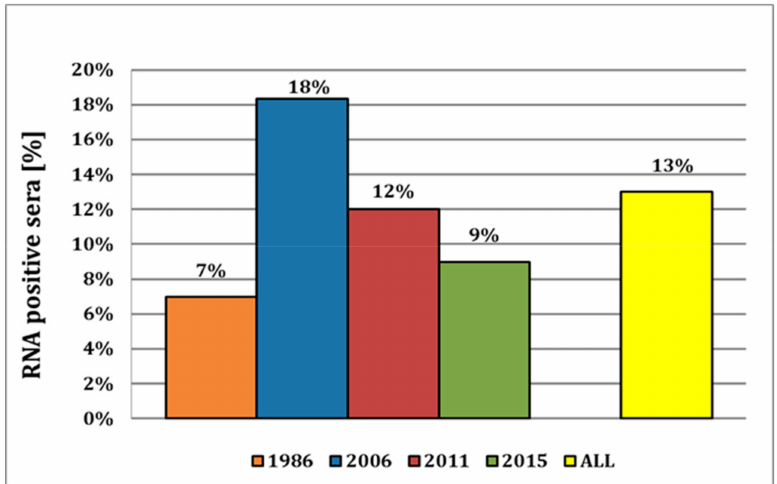
Figure 2. Virus prevalence of APPV in Switzerland from fattening farms. Relative number of APP virus prevalence in Switzerland from 1986 until 2015 with an overall viral prevalence of 13% in fattening